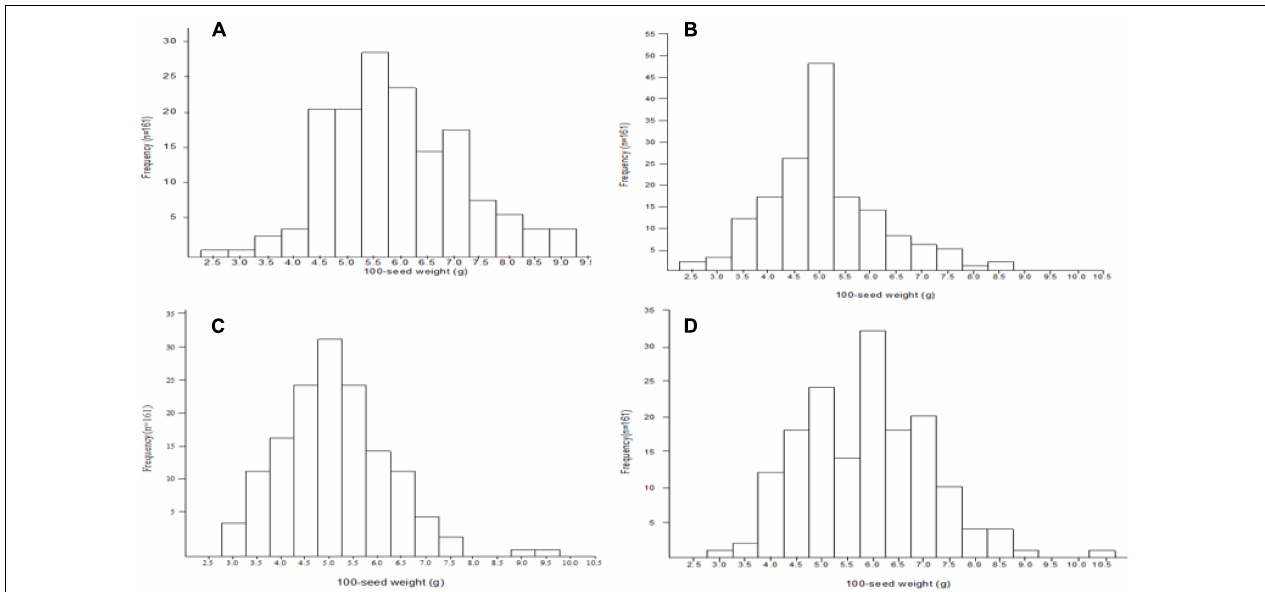
FIGURE 1 | Frequency distribution of 100-seed weight QTLs among the NJIR4P-RIL in the various environments ( A , B , C , and D for FY2012, JP2012, JP2013, and JP2014,